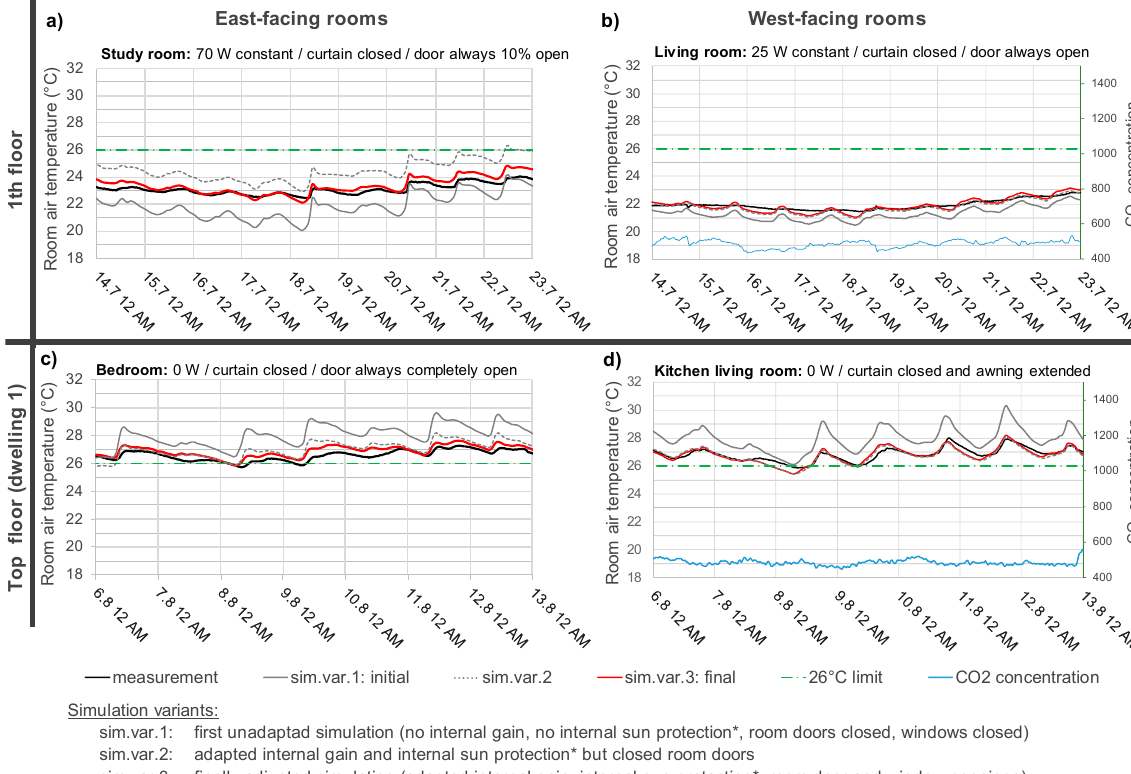
Simulation variants: sim.var.1: first unadaptad simulation (no internal gain, no internal sun protection*, room doors closed, windows closed) sim.var.2: adapted internal gain and internal sun protection* but closed room doors sim.var.3: finally adjusted simulation (adapted internal gain, internal sun protection*, room door and window openings) * including the activation of the sunsail at the balcony window frontage of the west oriented room in the top floor Figure 4. Monitored (black curve) and three variants of simulated (sim.var.) room temperature profiles for ( a , c ) east and ( b , d ) west façade oriented rooms of dwellings in the first and the top floor for periods of absence of residents (see relatively constant CO 2 concentration at typical outdoor level of 400 ppm). The simulation parameters for the individual rooms of the final calibrated simulation variant 3 are written above each diagram. A comparison of measured and simulated room temperature for all monitored rooms is depicted in the appendix (cf. Figure A3).